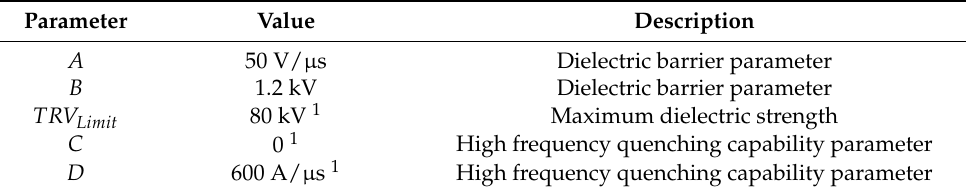
Table 2. Vacuum circuit breaker